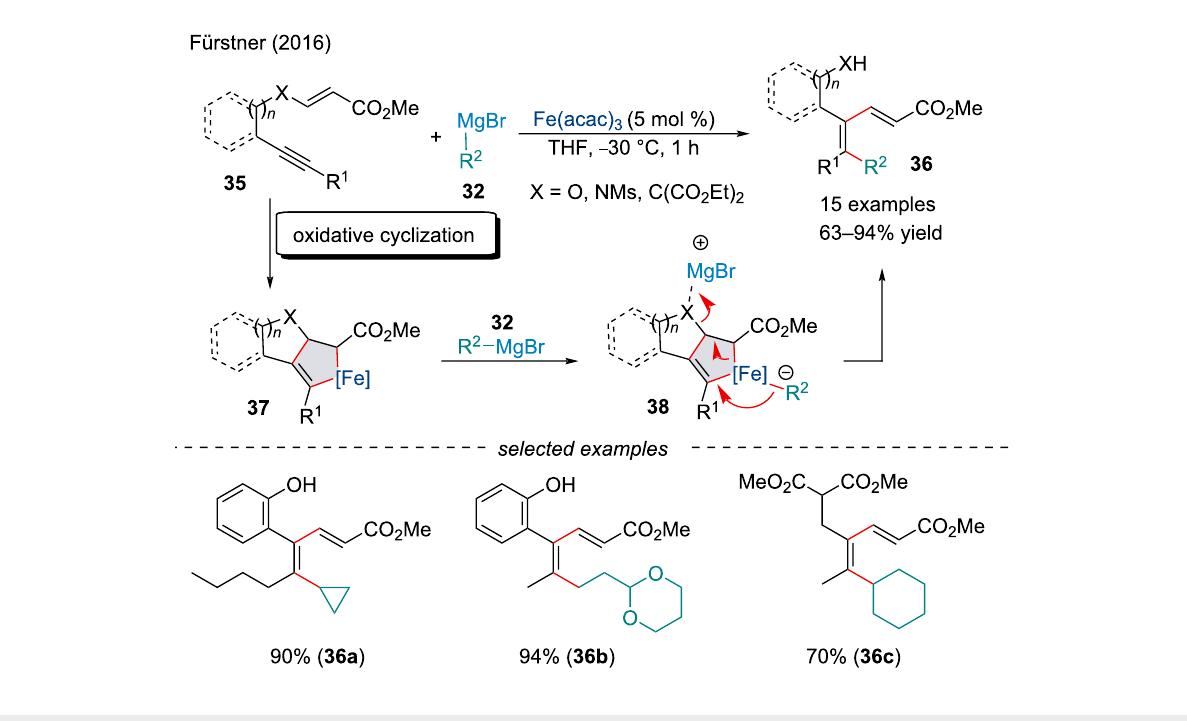
Scheme 7: Iron-catalyzed cycloisomerization/cross-coupling of enyne derivatives 35 with alkyl Grignard reagents 32 .